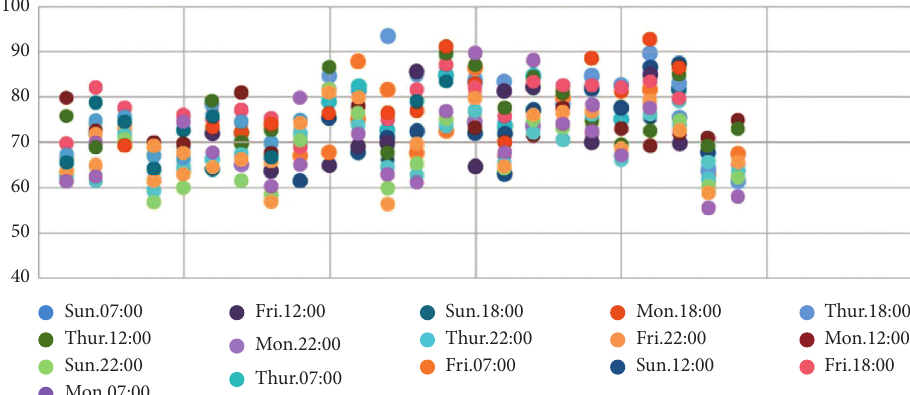
Figure 8: dB bitmap.